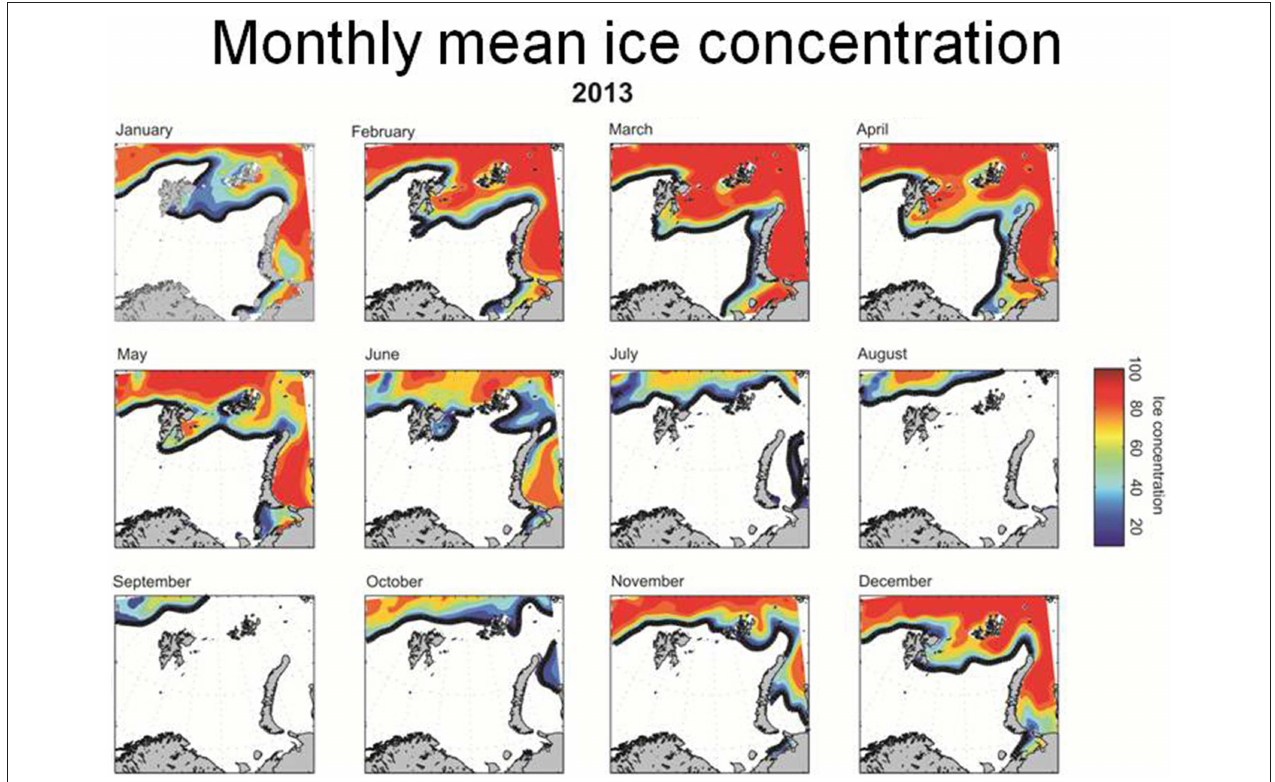
FIGURE 3 | Monthly ice coverage in the Barents Sea in